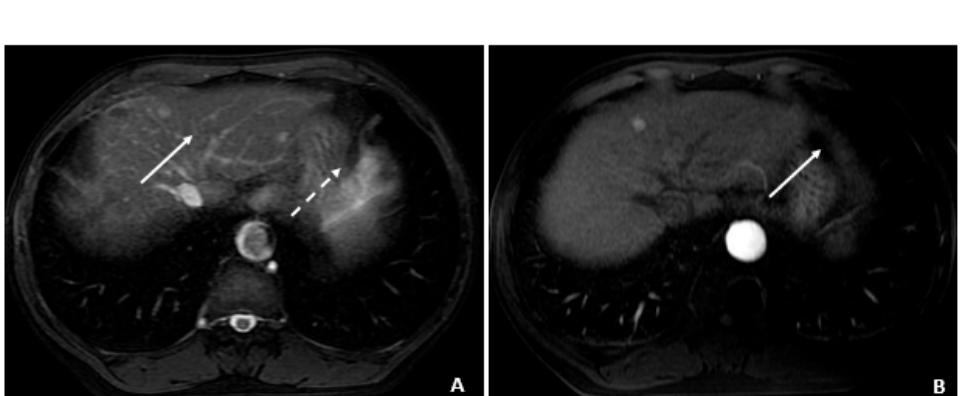
Figure 4. Initial MRI with normal AFP and elevated %L3 (July 2008). ( A ) The axial T2-weighted gradient echo image shows a small hyperintense lesion (arrow) in segment 4A. A second hyperintensity (dashed arrow) corresponds to a hemangioma. ( B ) The corresponding axial T1-weighted fat-suppressed arterial-phase postcontrast image shows hyperenhancement (arrow) in the lesion subsequently found to be a small HCC, although currently without associated features to clinch the diagnosis. Without washout, capsule appearance, or other typical HCC findings, the lesion is indeterminate.